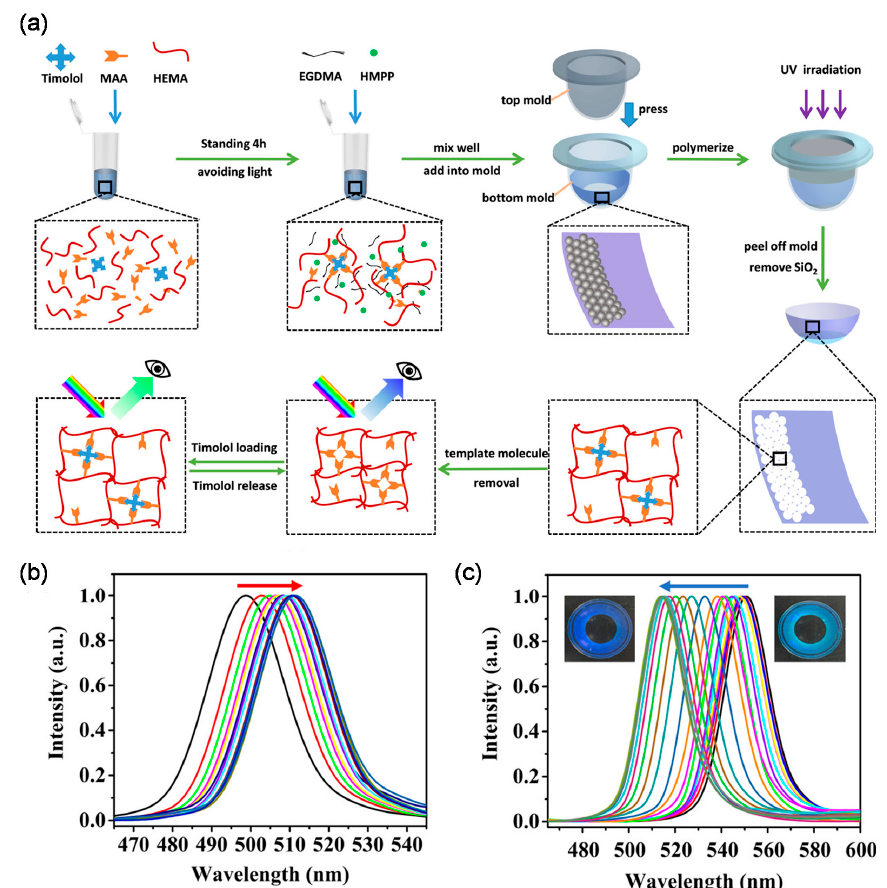
Figure 4. ( a ) Schematic of the preparation procedure of molecular imprinted structural color contact lenses; ( b ) change of reflection peak of the lenses during drug loading in pH 6.5 timolol loading solution; ( c ) change of the reflection peak of the lenses during drug release in ATF. Inset: the digital photographs of the lenses at the beginning of release (the equilibrium of pH, right) and at equilibrium of release (left). Adapted with permission from Deng et al. [91].